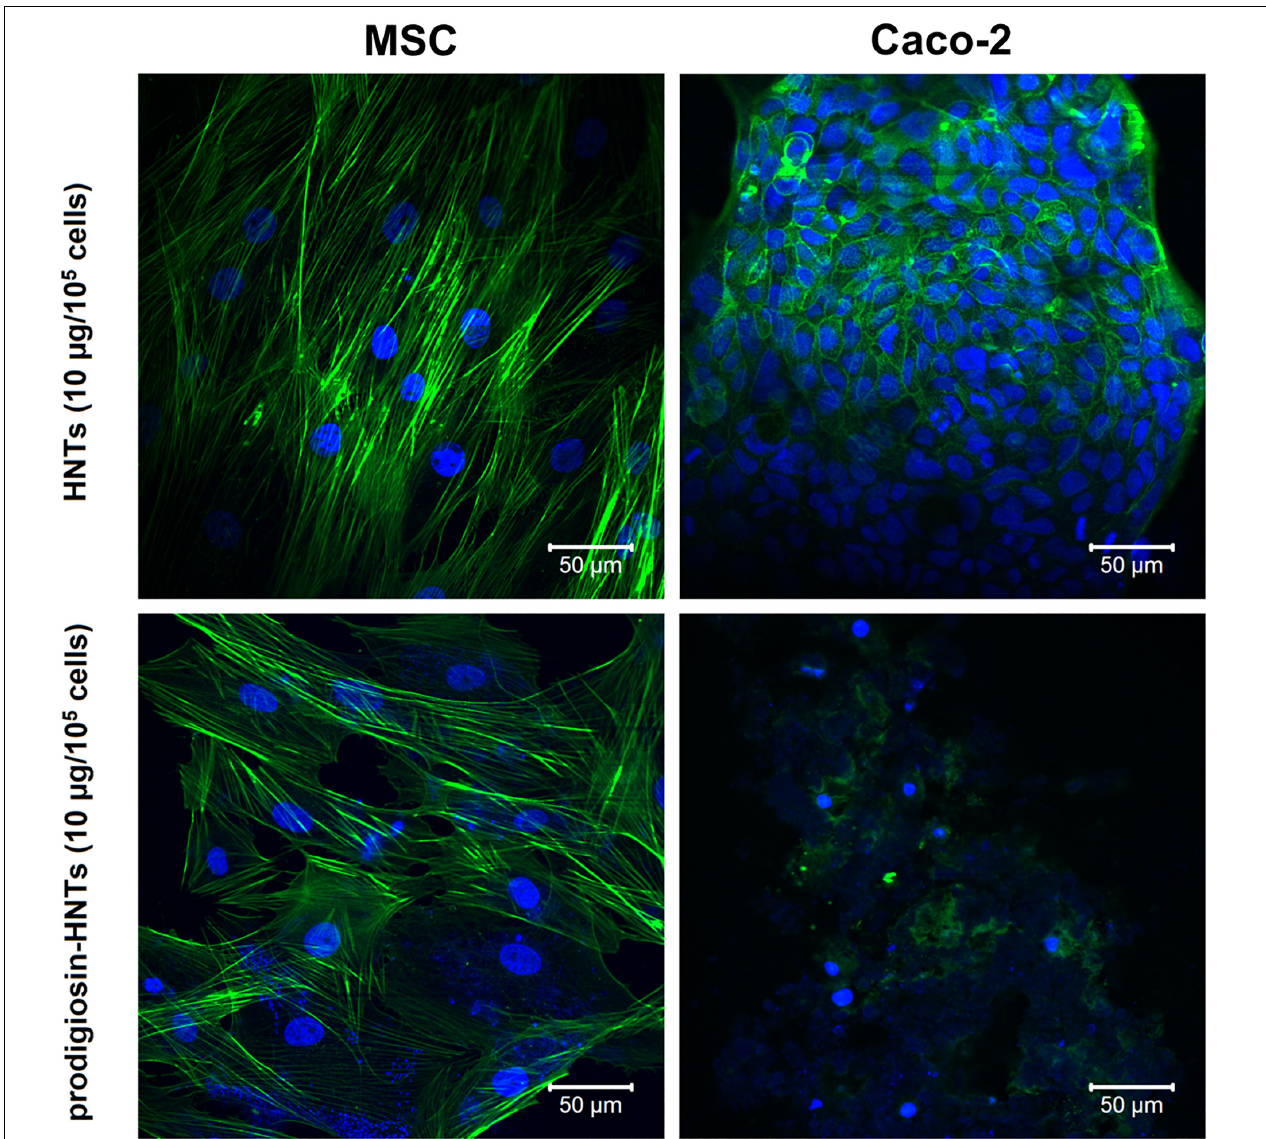
FIGURE 6 | F-actin visualization in non-malignant (MSC) and malignant (Caco-2) cells after incubation with HNTs and prodigiosin-HNTs. Note the disorganization of F-actin after treatment of Caco-2 cells with prodigiosin-HNTs. MSC and Caco-2 cells where stained with DAPI (blue) and Alexa Fluor 488 R (cid:13) phalloidin (green). Figure shows a cytoskeleton disruption in cancer cells and the absence of such effect in MSCs (bottom images). Upper images clearly demonstrate that the occurrence of such effect is due to the prodigiosin